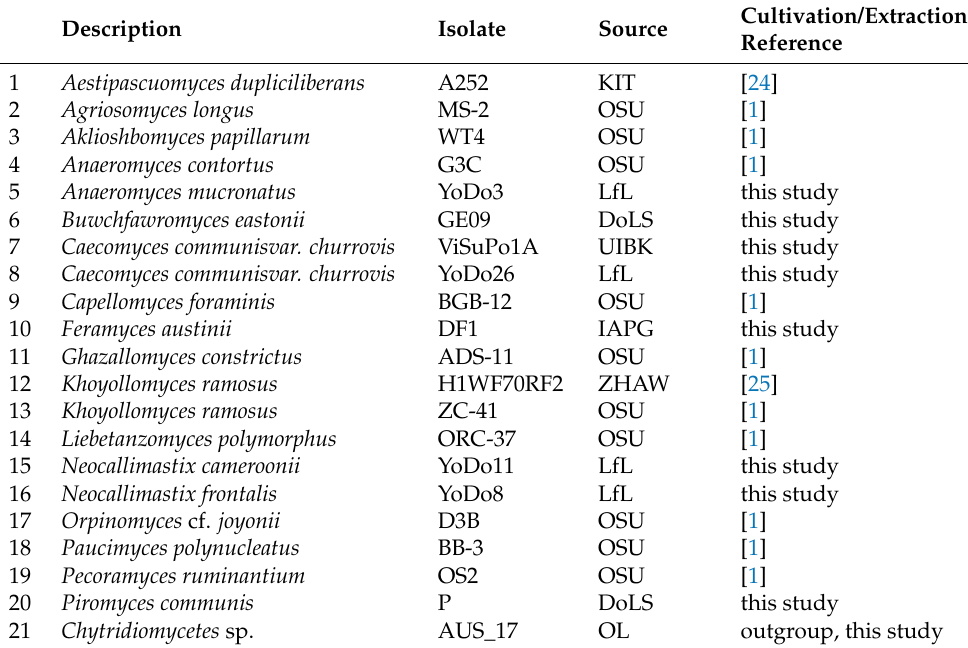
Table 1. Neocallimastigomycetes isolates (pure cultures) and DNA extracts used as in vitro